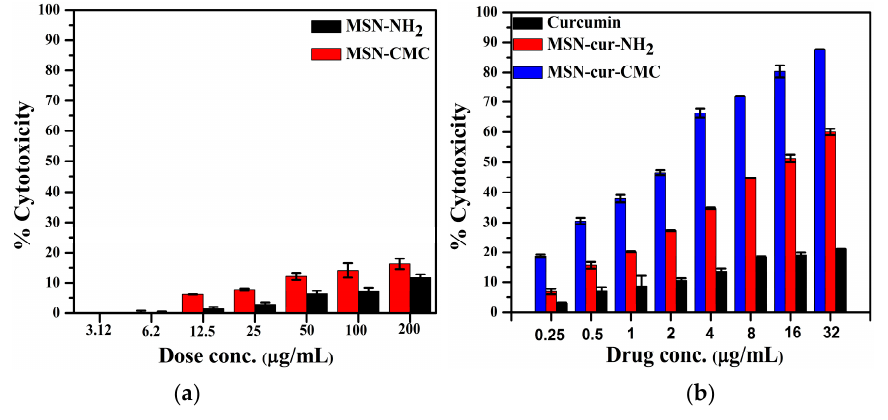
Figure 6. ( a ) % Cytotoxicity of MDAMB 231 cells incubated with MSN-NH 2 and MSN-CMC and ( b ) % Cytotoxicity of MDA-MB-231 cells incubated with free curcumin, MSN-cur-NH 2 and MSN-cur-CMC keeping the amount of curcumin same in all the samples ( x axis represents concentration of free curcumin and curcumin incubated in MSN-NH 2 and MSN-CMC).